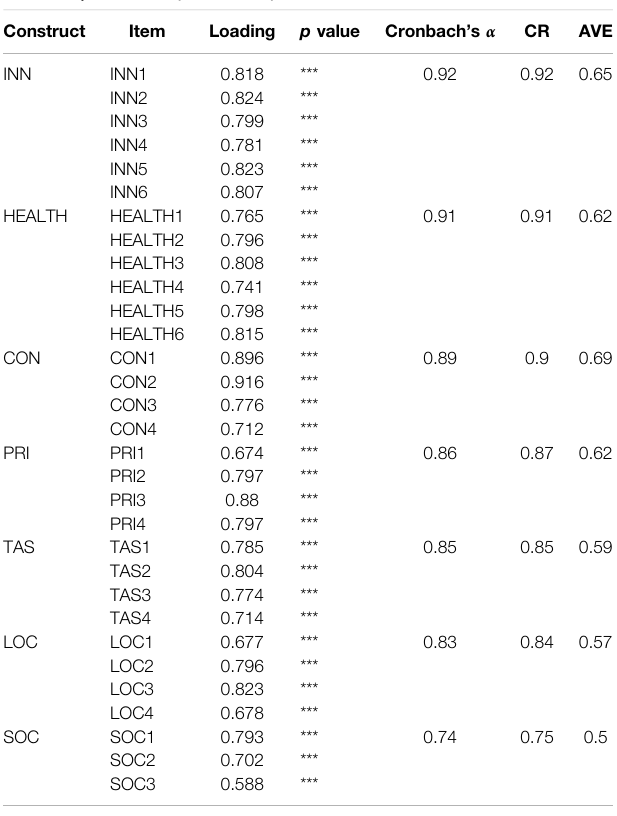
TABLE 5 | Con fi rmatory factor analyses.